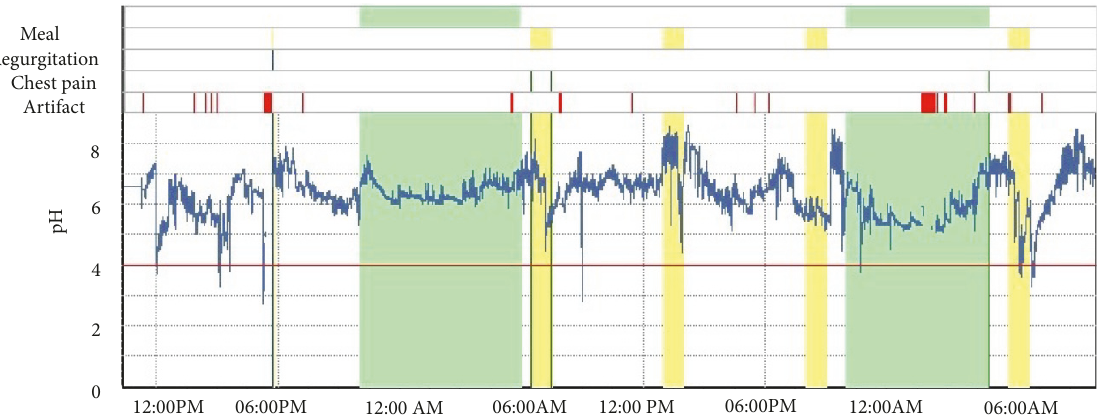
Figure 1: Bravo pH testing did not show any evidence of acid